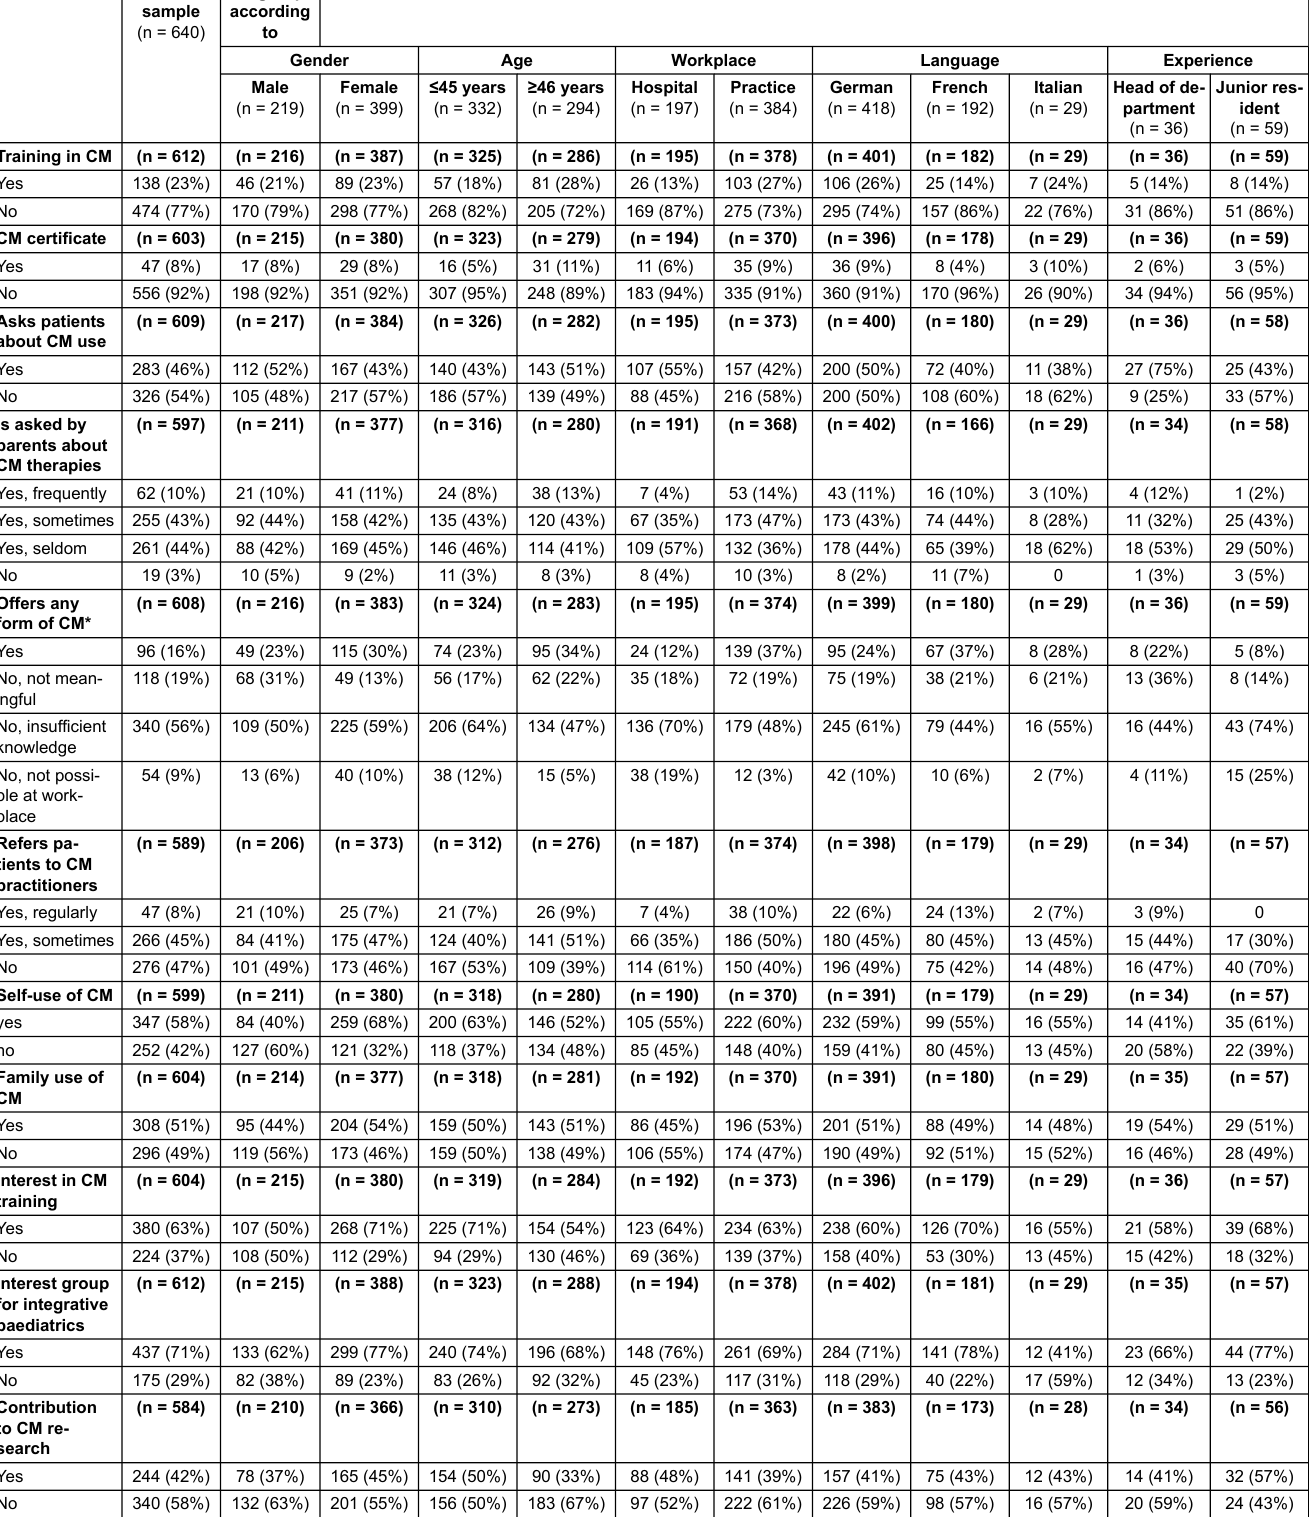
Table 3: Results from the overall sample and the subgroup analysis. Overall